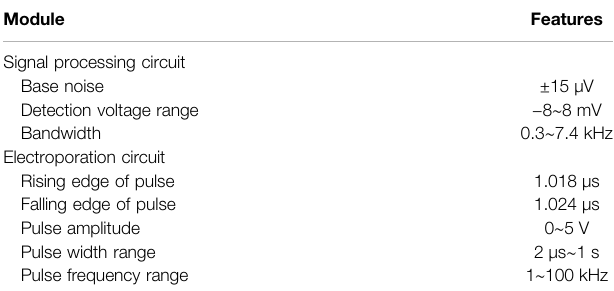
TABLE 1 | Speci fi cations of the electrical signal recording and electrical pulse regulating system.